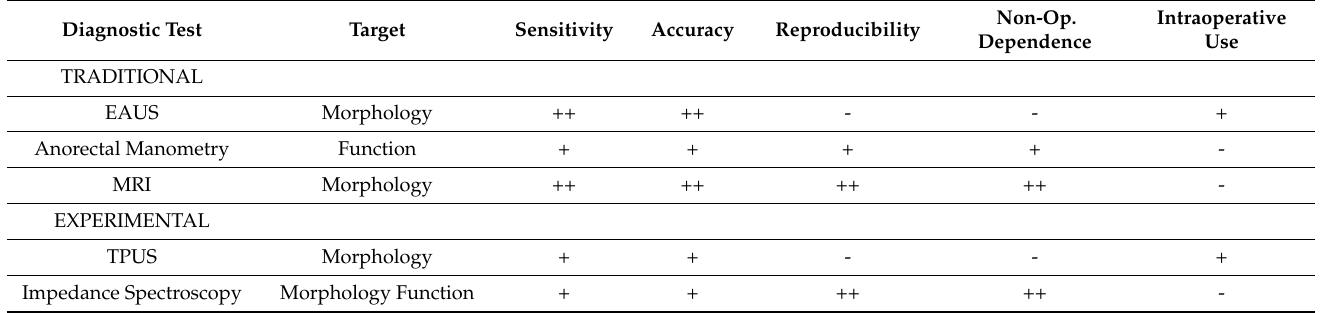
Table 1. Comparison between the available diagnostic tools for the assessment of OASIS. Diagnostic